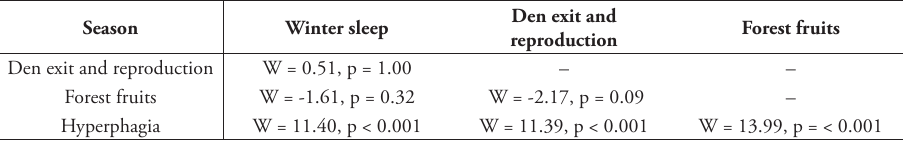
Table 3. Comparison of seasonal daily displacement length of brown bears in Eastern Romanian Car- pathians and Subcarpathians (Dunn test with Bonferroni adjustment, α = 0.05). Den exit and Season Winter sleep Forest fruits reproduction Den exit and reproduction W = -6.51, p < 0.001 – – Forest fruits W = -8.35, p < 0.001 – Hyperphagia W = -7.64, p <